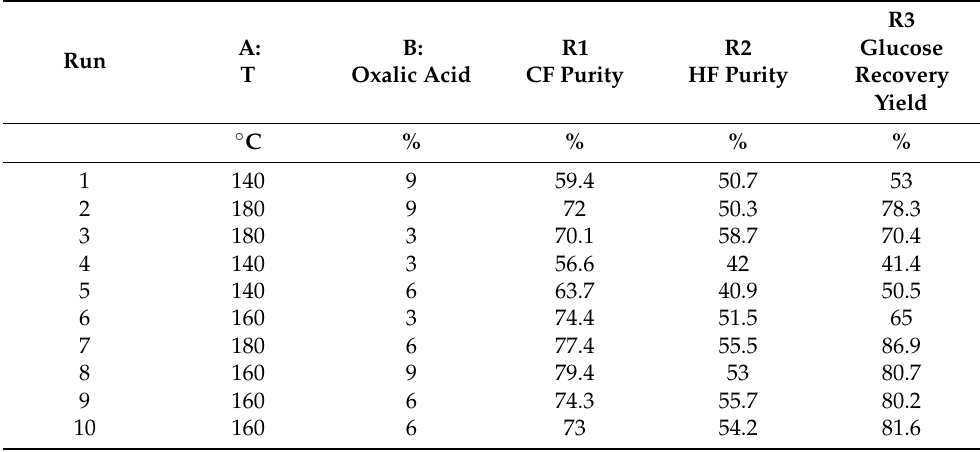
Table 3. Experimental design plan and experimental data obtained for the pretreatment and fraction- ation of ER with butanol